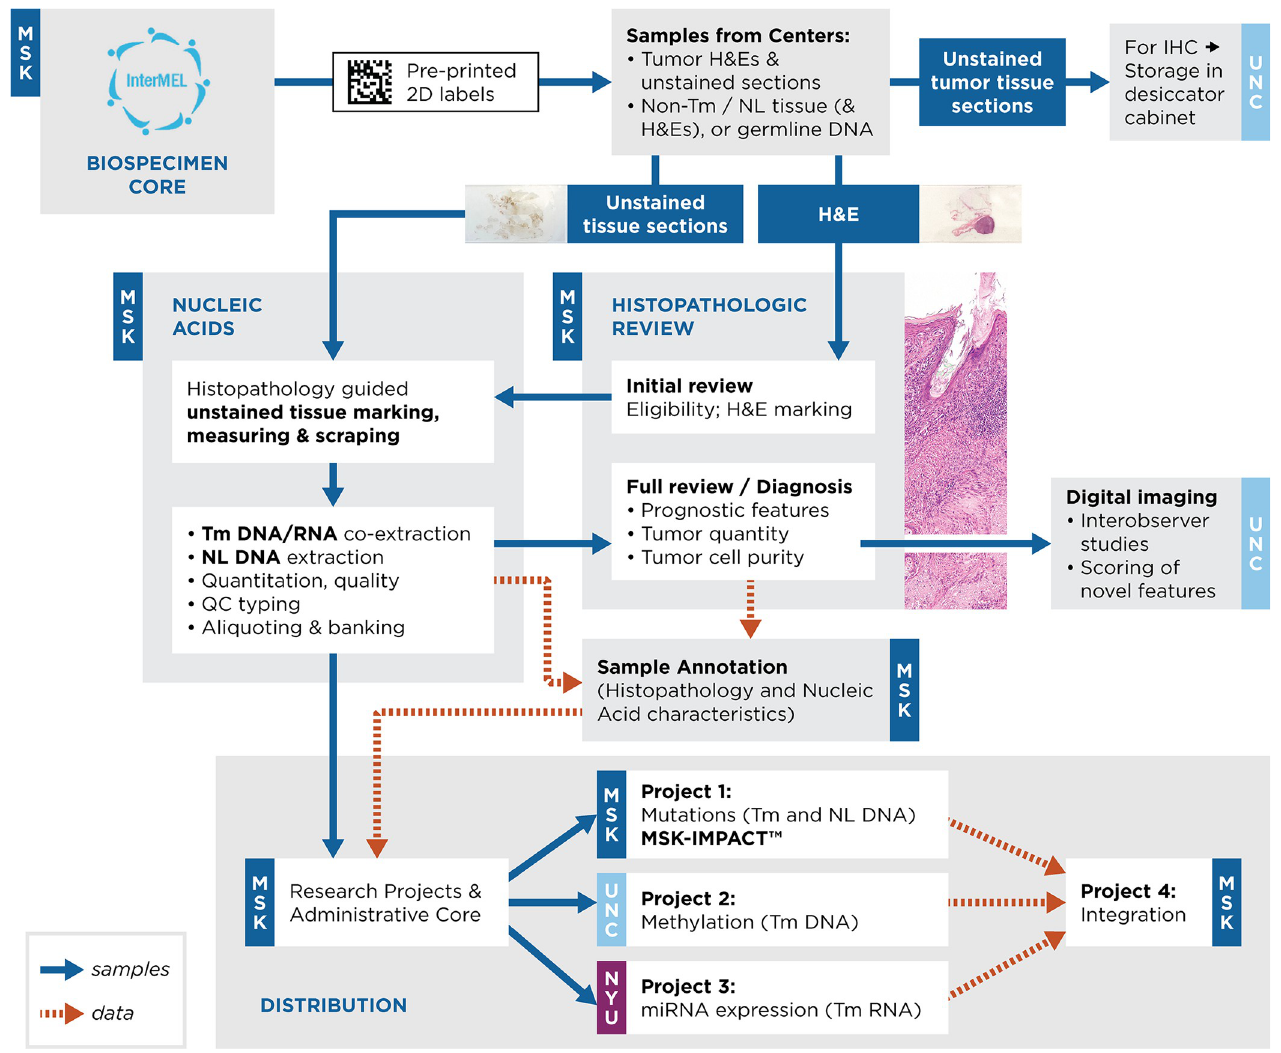
Fig 1. Summary of specimens and data flow in